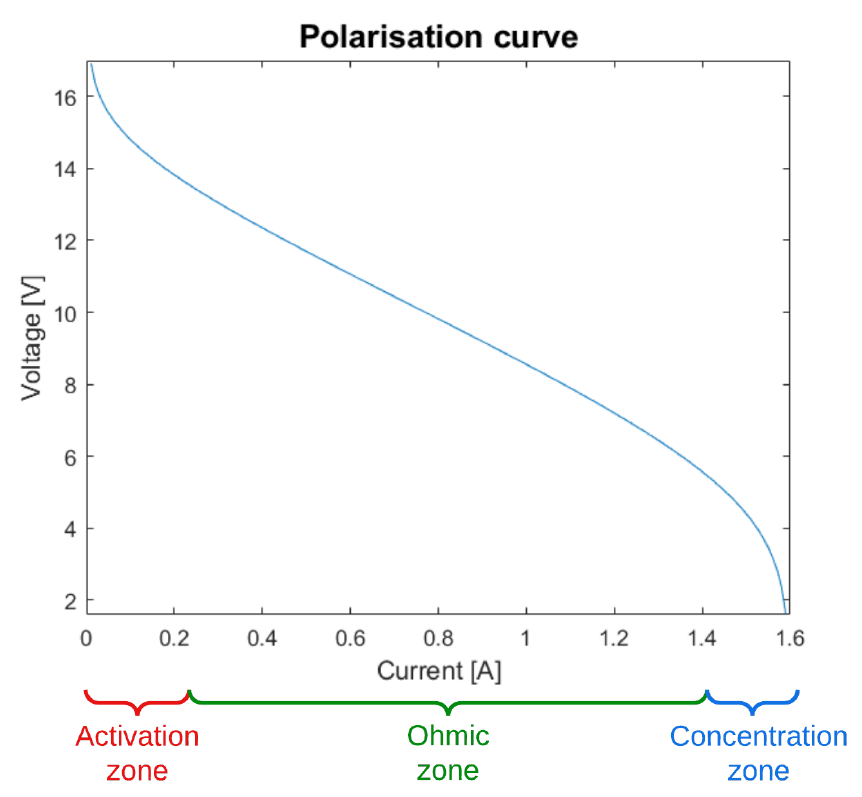
Figure 3. Polarisation curve of an HT-PEMFC (20 cells, area of 1 cm 2 and temperature of 127 ◦